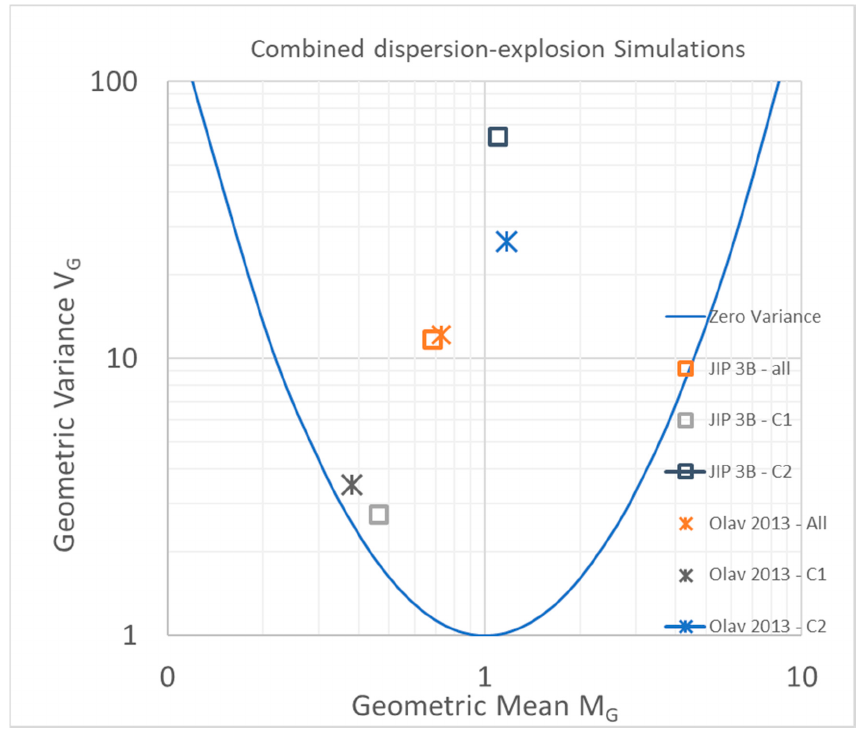
Figure 6. An MV diagram summarising the performance of the ‘direct dispersion-explosion simulations’ using FLACS. No ESC was assumed. Non-homogeneous flammable gas clouds were calculated and used directly as input to explosion simulations. Results from [3] in crosses and the Phase 3B reports [17] in hollow squares. Note about legend: a line is added to the start of a new symbol to allow its easy identification.